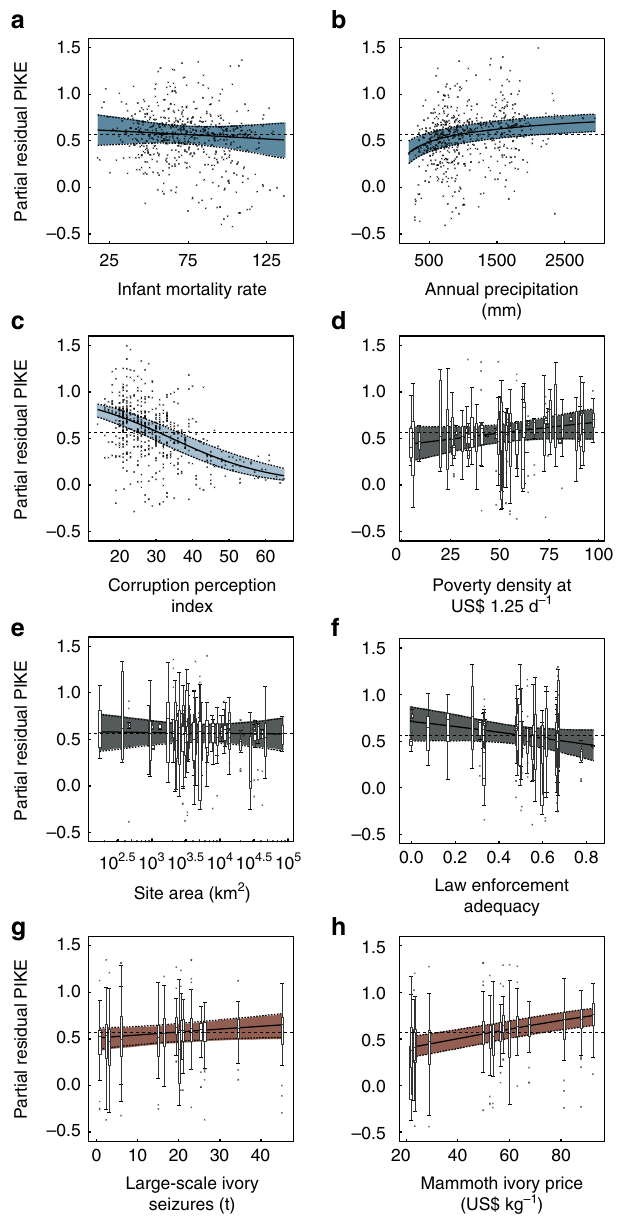
Fig. 3 Conditional relationships between key covariates and the estimated proportion of illegally killed elephants (PIKE). Site by year covariates (steel blue) a infant mortality rate and b annual precipitation, the country by year covariate (light blue) c corruption perception, the site level covariates (dark grey), d poverty density, e site area, and f law enforcement adequacy, and the annual (brick red) g large-scale ivory seizures, and h ivory price. Error envelopes represent 90% credibility intervals from 3000 MCMC samples, horizontal dashed lines illustrate the estimated intercept median. All effects plots are overlaid with response-scale partial residuals (points for site and country by year covariates and boxes for site and annual covariates). Boxplot centre lines represent median estimates, box bounds fi rst and third quartiles, and whiskers 90% CIs. All plots are scaled the same to make effect sizes directly